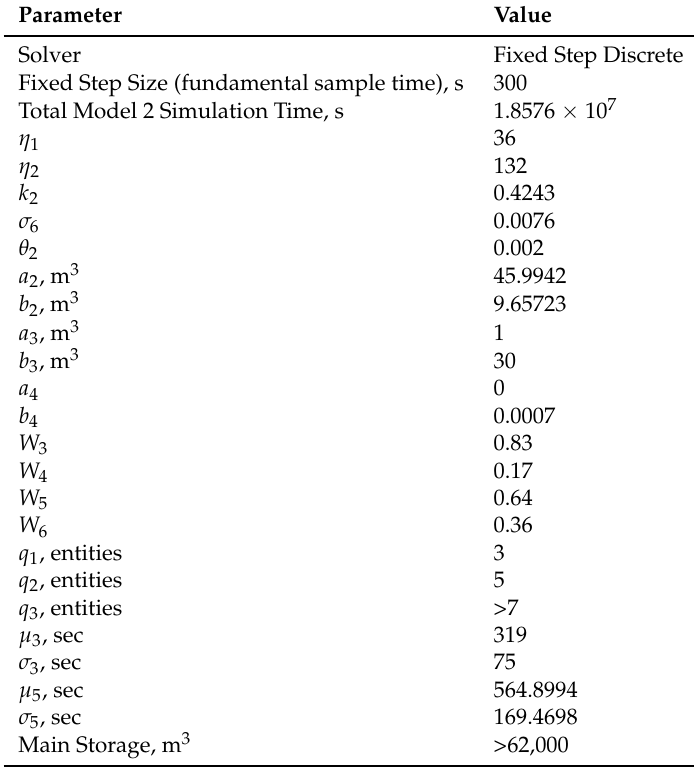
Table 2. Model 2